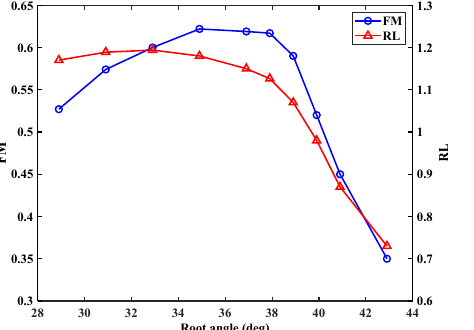
Figure 18. VDDF lift force calculation in hovering.